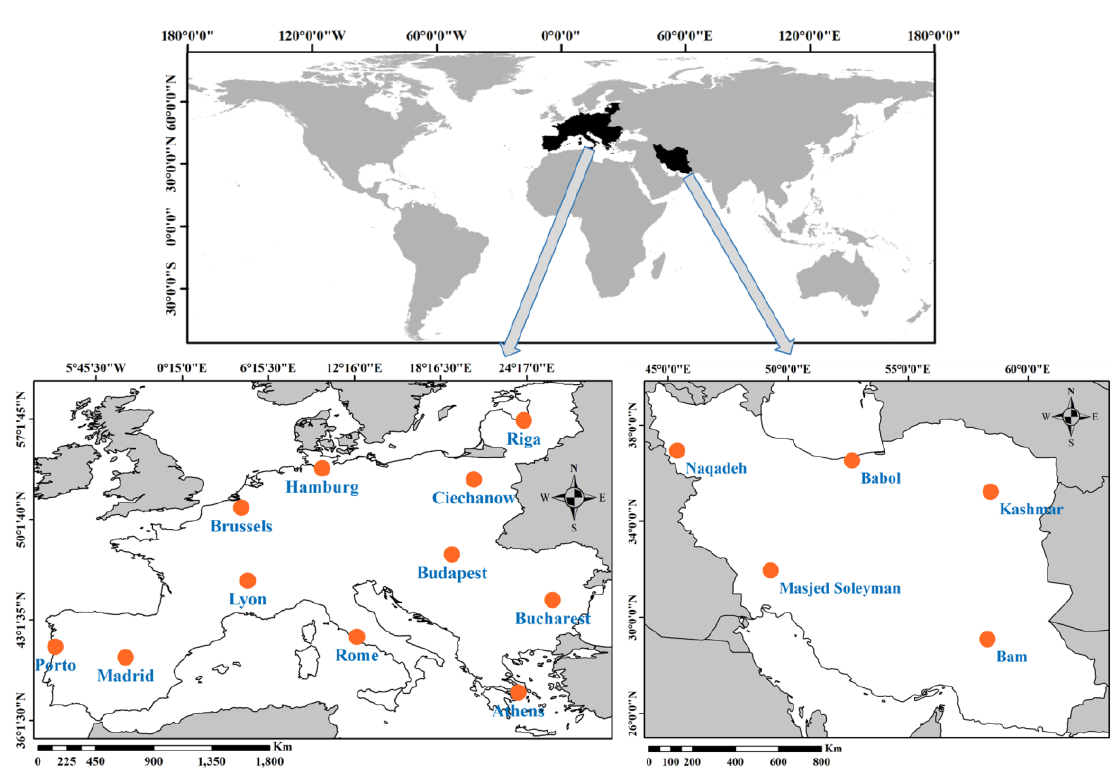
Figure 1. The geographical locations of test sites and cities.